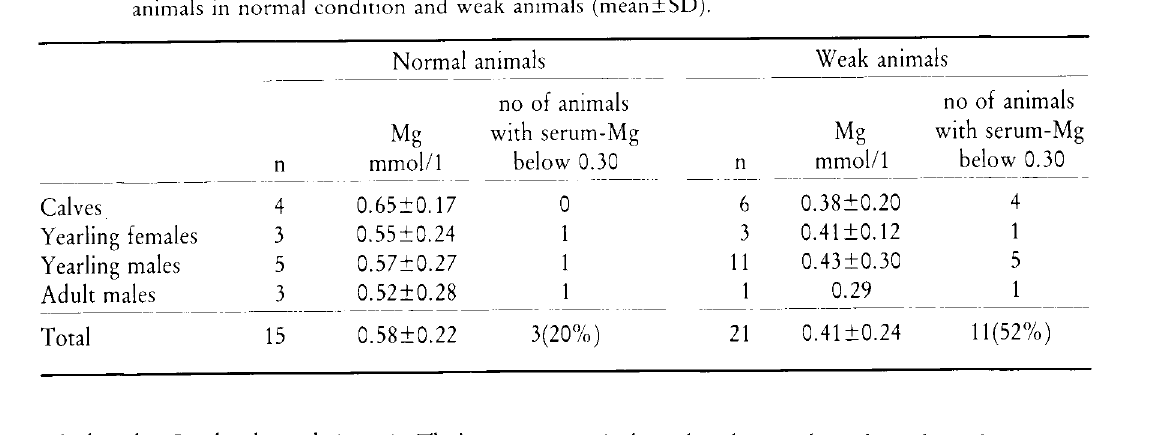
Table 4. Magnesium levels in serum from reindeer slaughtered in February/March: comparision between animals in normal condition and weak animals